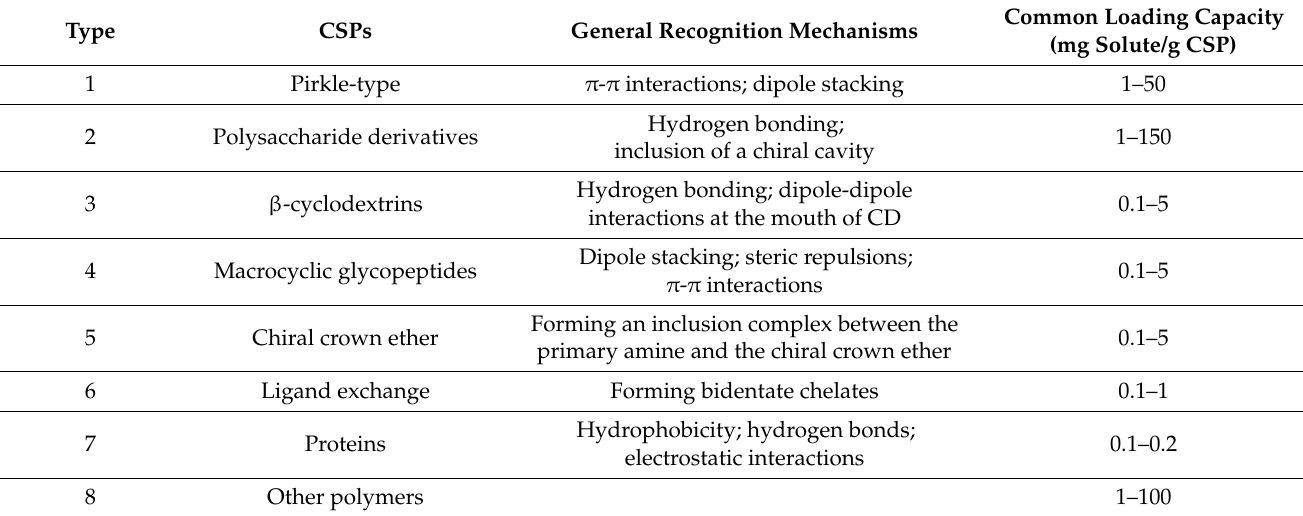
Table 3. Types of CSPs and their general recognition mechanisms with loading capacity